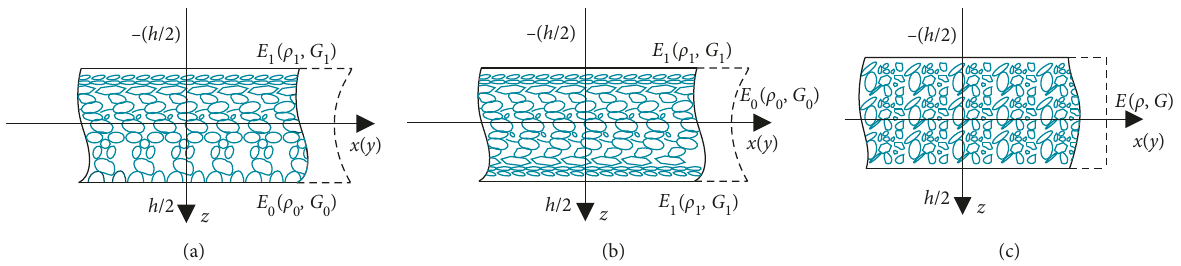
Figure 2: Three typical kinds of porosity distributions: (a) type I nonsymmetric distribution; (b) type II symmetric distribution; (c) type III uniform distribution.